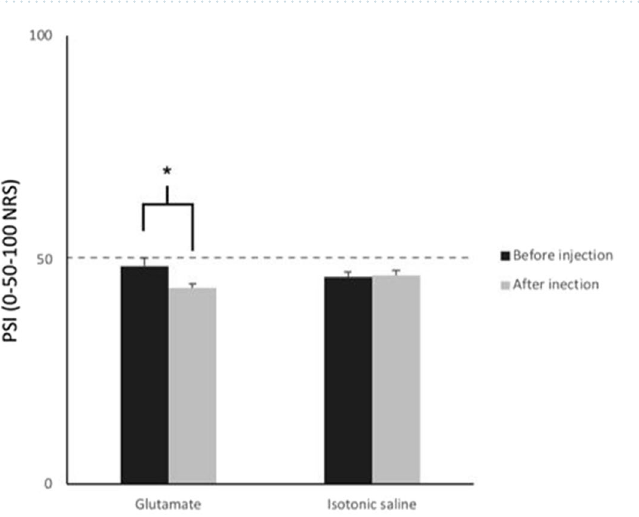
Figure 3. Referred sensations and perceived sensation intensity following injections into the temporalis muscle. A visual representation (graph) of the recorded referred sensation (RS) frequency and perceived sensation intensity (PSI) scores during the 10 min after the injection of glutamate (G) and isotonic saline (IS) into the temporalis muscle. * P < 0.05, # P < 0.001, ANOVA and McNemar’s test.